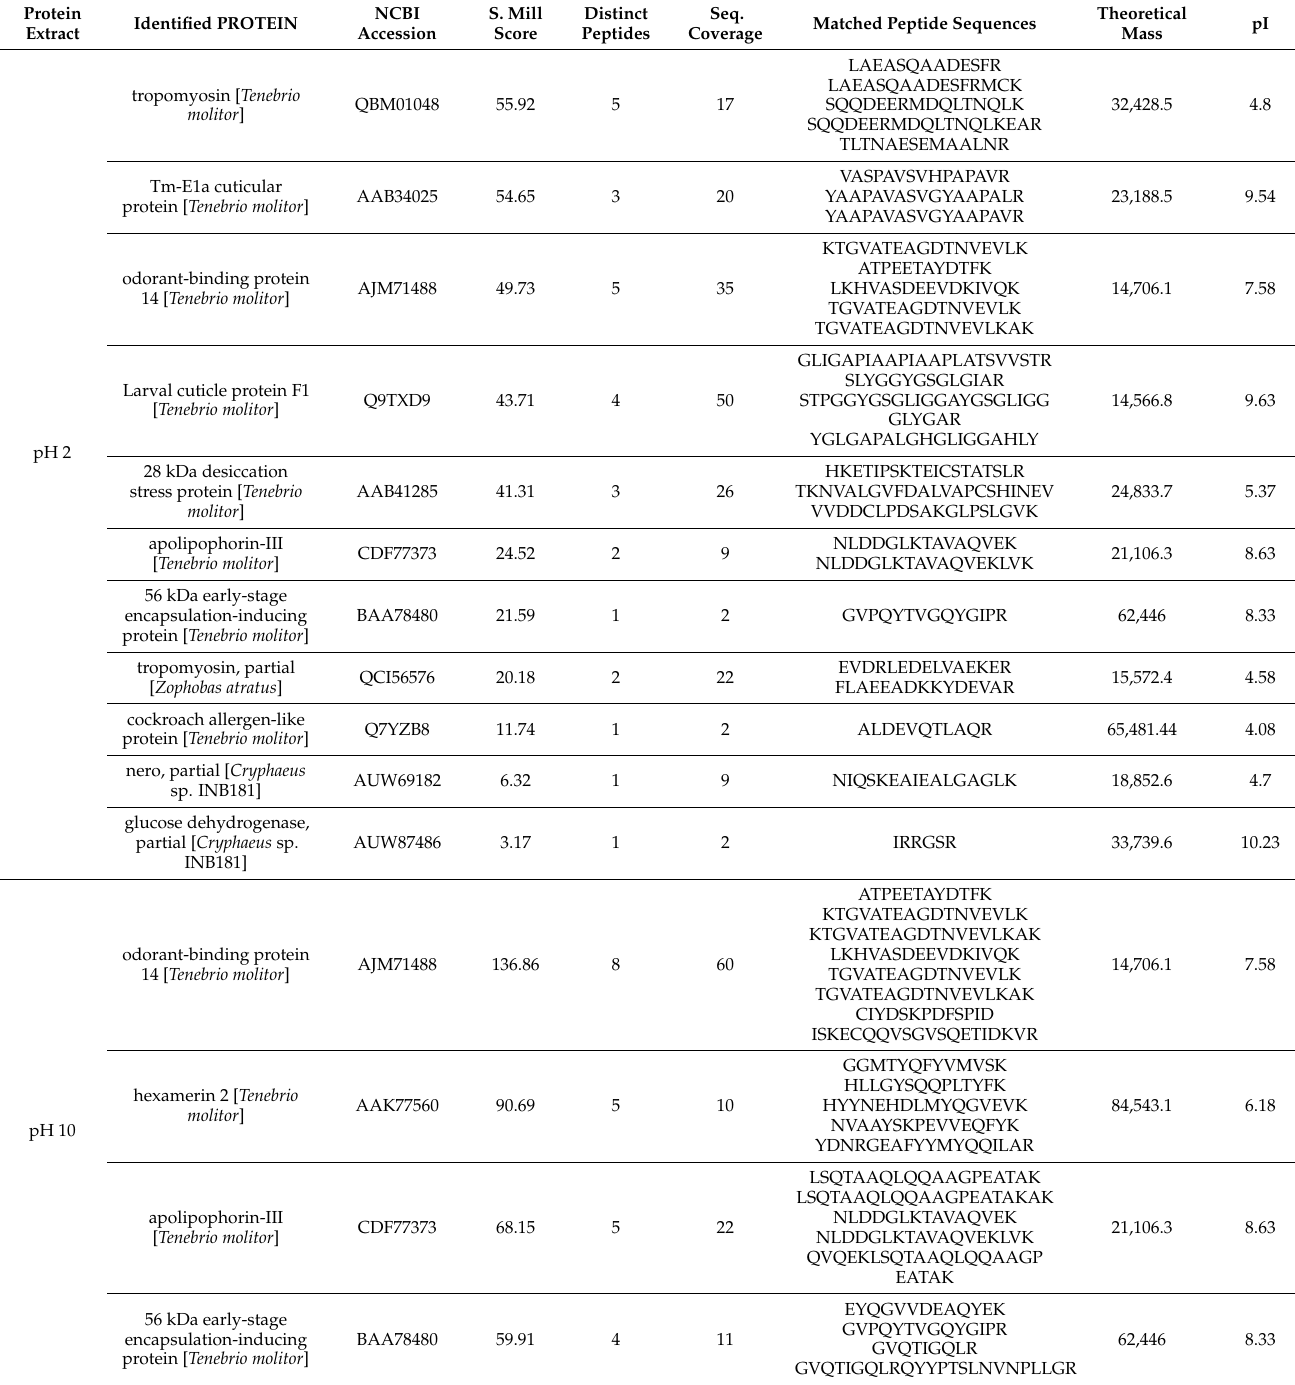
cuticle protein, proteins involved in muscle contraction (tropomyosin), can be classified as structural proteins, while α -amylase, glucose dehydrogenase and aldehyde oxidase represent different enzymes. Table 3. List of proteins identified by LC-MS/MS in the digests of acidic and alkaline extracts of proteins of yellow mealworm